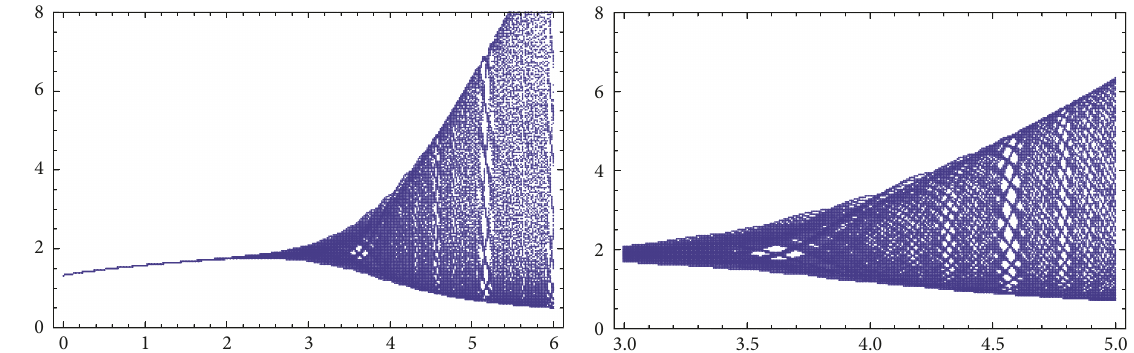
𝐶 1 curve Γ(𝜆) encircling the origin if 𝜆 < 𝜆 Γ(𝜆 ) = 0 0